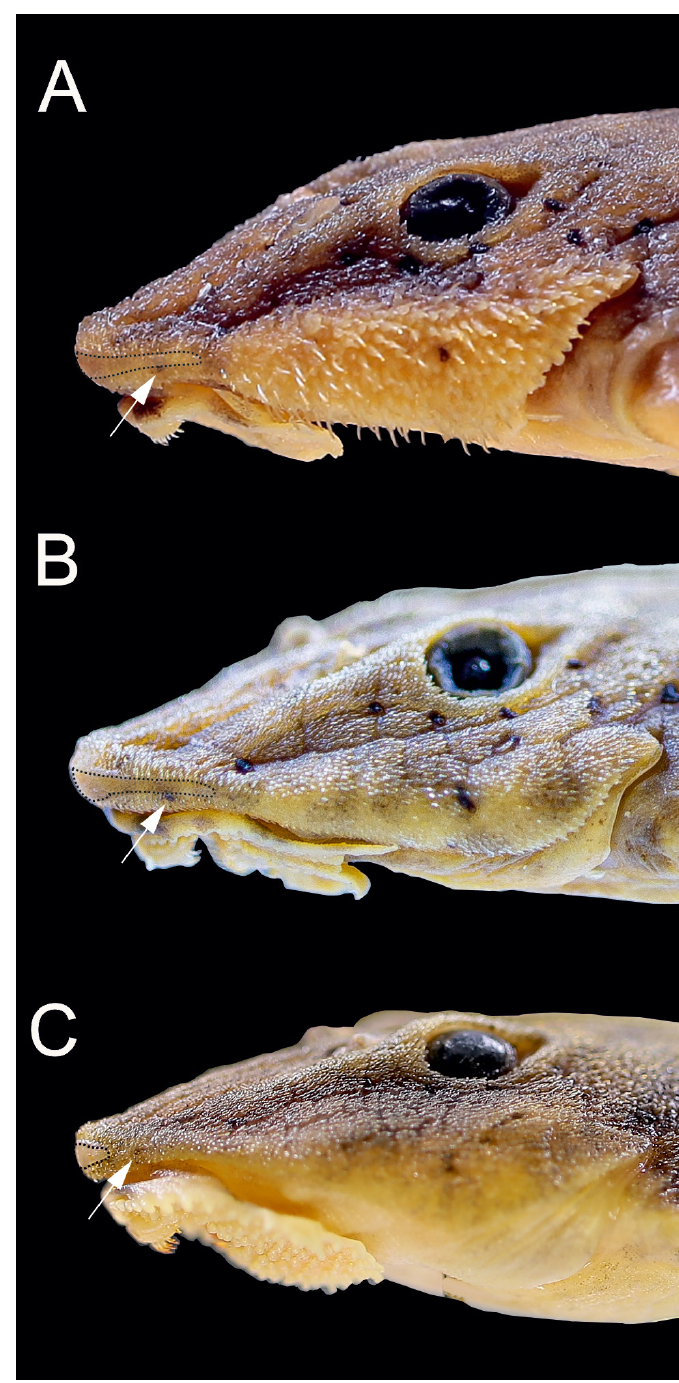
FIGURE 4 | Lateral view of head showing extend of naked skin area (dashed line) of the snout relative to anterior pore (indicated by arrow) on sensory line system in ( A ) Rineloricaria nudipectoris , holotype, MNRJ 49345, male, zawadzkii , MNRJ 38254, female, 98.7 mm